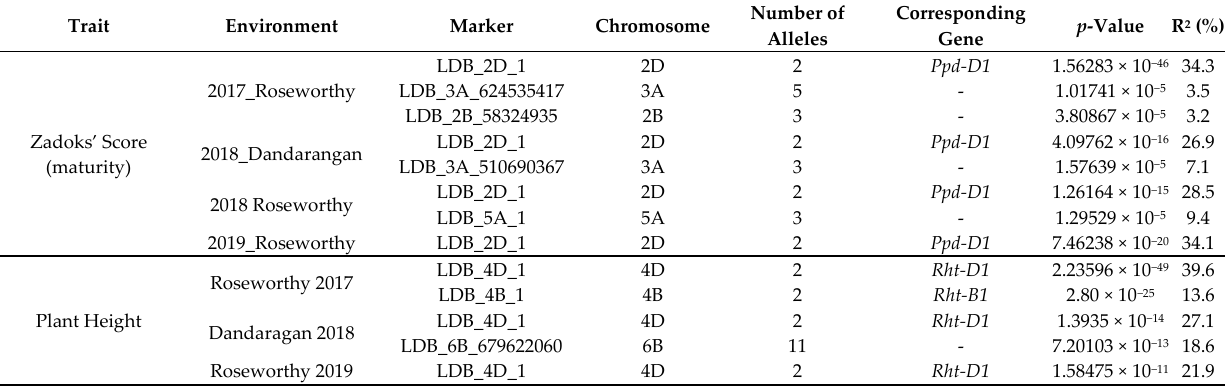
Table 2. QTL associated with maturity and plant height detected in four trial environments.